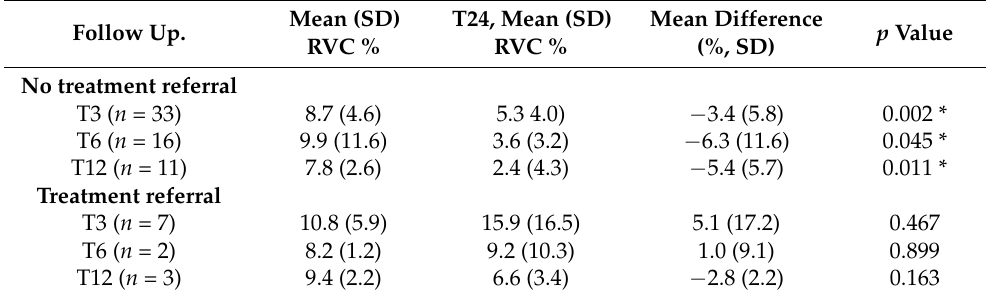
Table 5. Group level data of the mean RVC of the LE patients, over three time points (the results are obtained by paired t